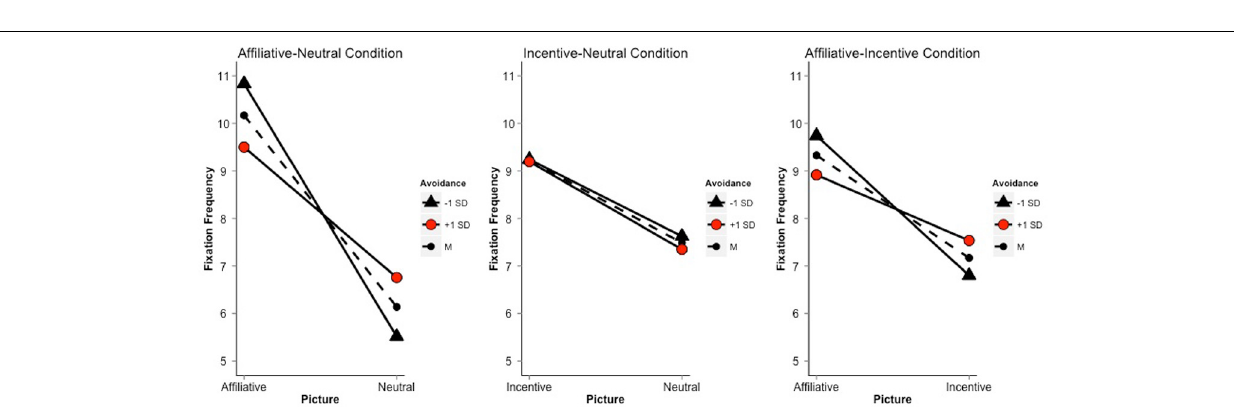
FIGURE 3 | Simple slopes of picture on fixation frequency for ± 1 SD and the mean (dashed line) of